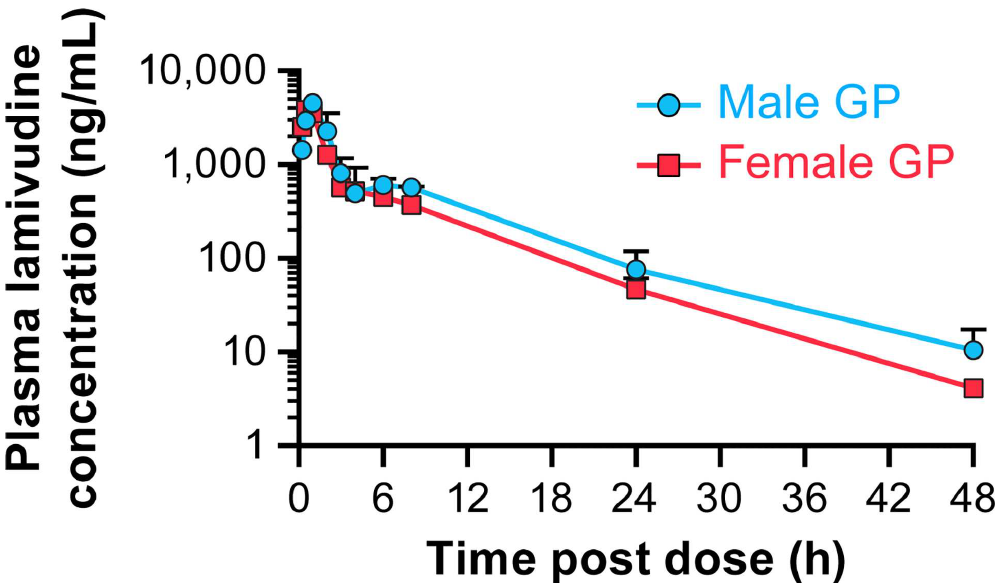
Fig 6. Pharmacokinetic study of lamivudine in guinea pigs. Plasma concentrations of lamivudine in male and female Hartley guineapigs after a singleoral dose, 60 mg/kg. Each data point representsthe mean ± SD of n = 3 guineapigs except for the 48 h time point in females, n =